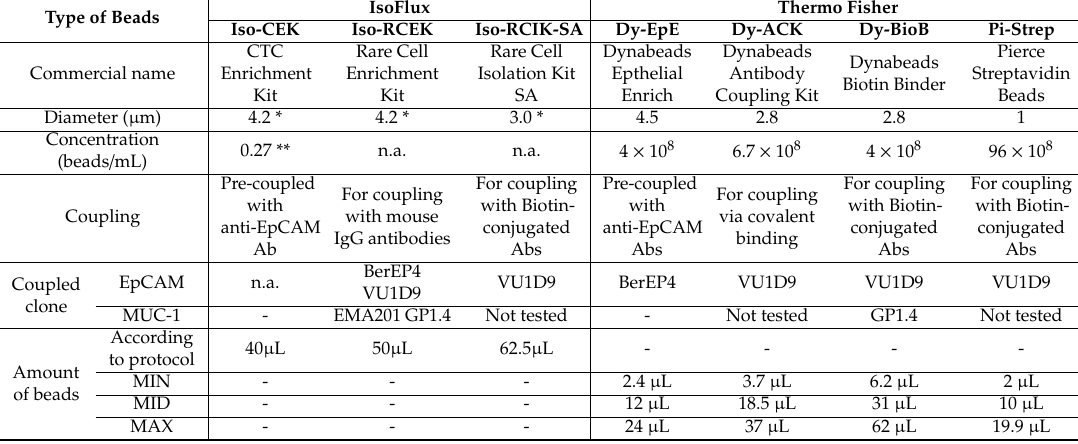
Table 1. Beads used for enrichment on the IsoFlux and KingFisher